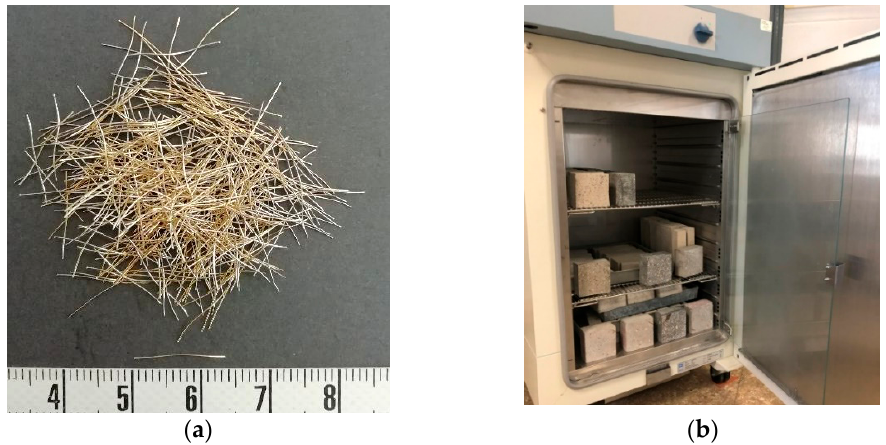
Figure 1. ( a ) Steel fibres used in the mixes; ( b ) Specimens in the climate chamber. Concretes C30, C50 and C90 were prepared with the aforementioned cement, and limestone aggregates consisting in 0/4 sand, 4/7 gravel and 4/12 gravel. The mix characteristics and respective compressive strength values are found in Table 1. The UH concrete with 2% of volume of fibres is a UH with a deflection-hardening behaviour, while the UH concrete with 1% of volume of fibres is a UH with a limit behaviour between deflection-hardening and -softening [48]. Table 1. Mixture proportions of concretes (kg/m 3 ) and compressive strength (MPa).